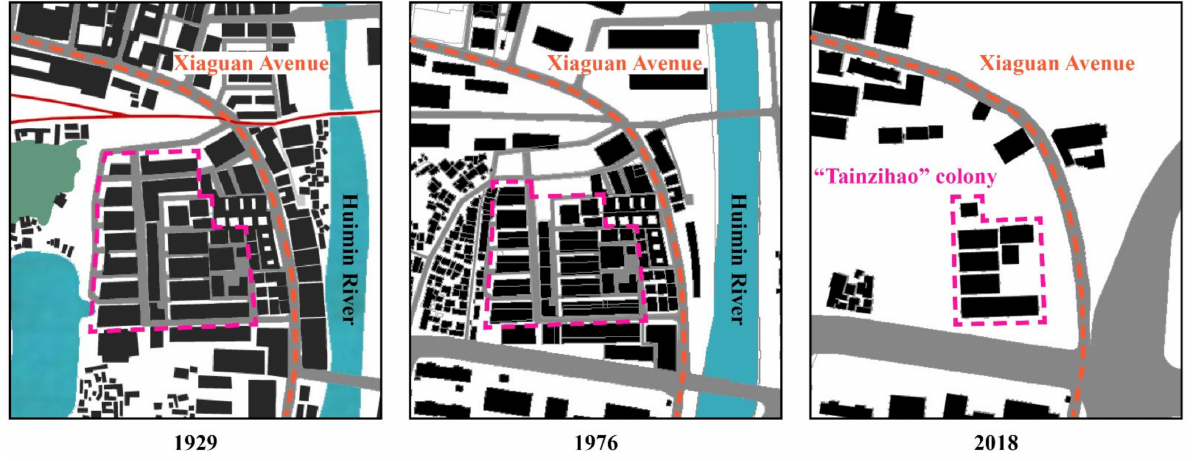
Figure 5. The changes of buildings in the “Tianzihao” colony from 1929 to